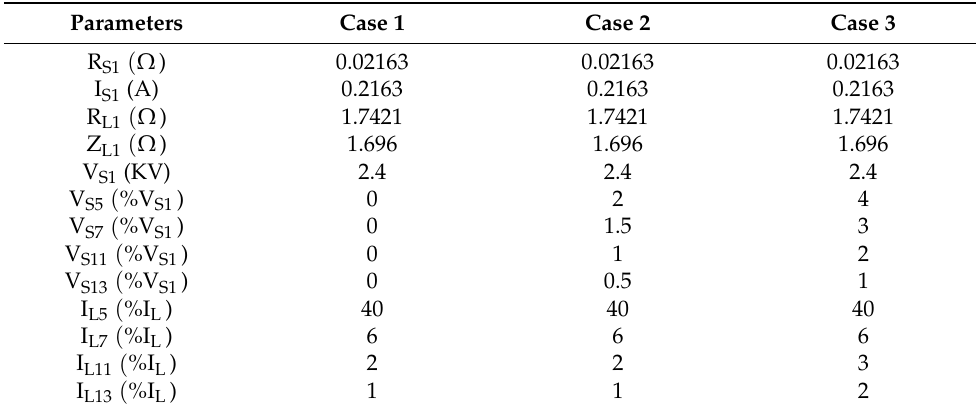
Table 1. The parameters of case studies for configuration 1 of